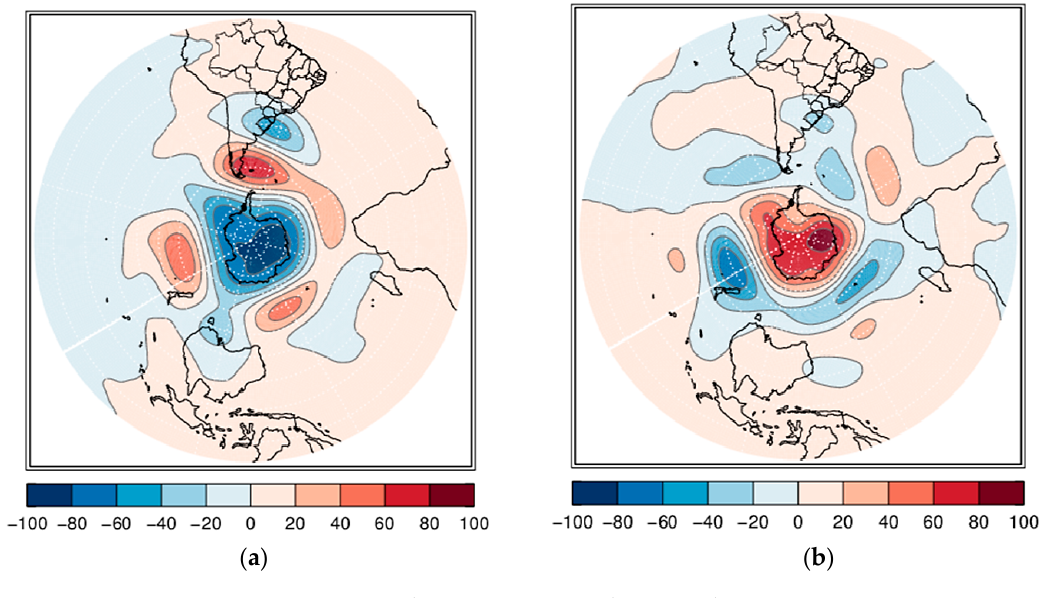
Figure 12. The same as Figure 9 but at 200 hPa.